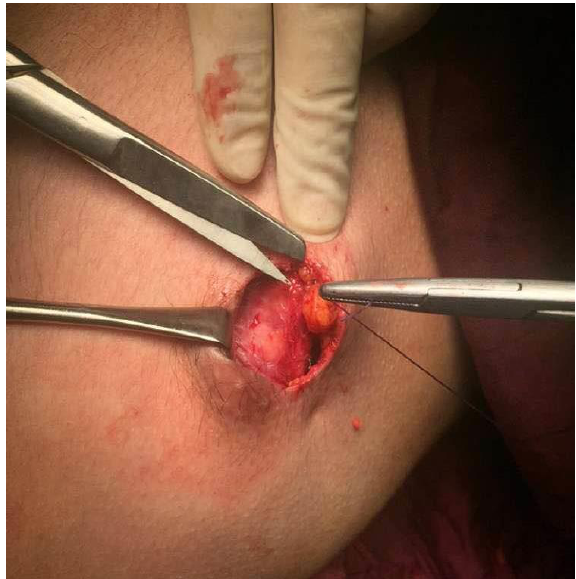
(Figure 5) Quilting suture between skin flap and derlying fascia Figure 6 (a &b) Simon 3 Gynecomastia preoperative marking and the post-operative